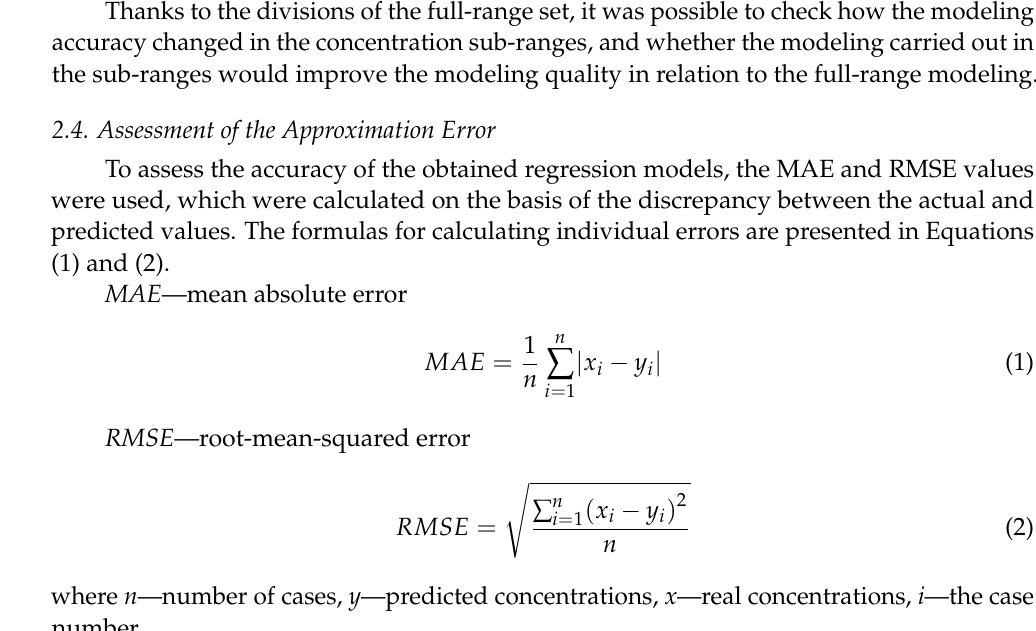
Figure 4. The scheme of the division into sub-ranges for the Z ł oty Potok station.